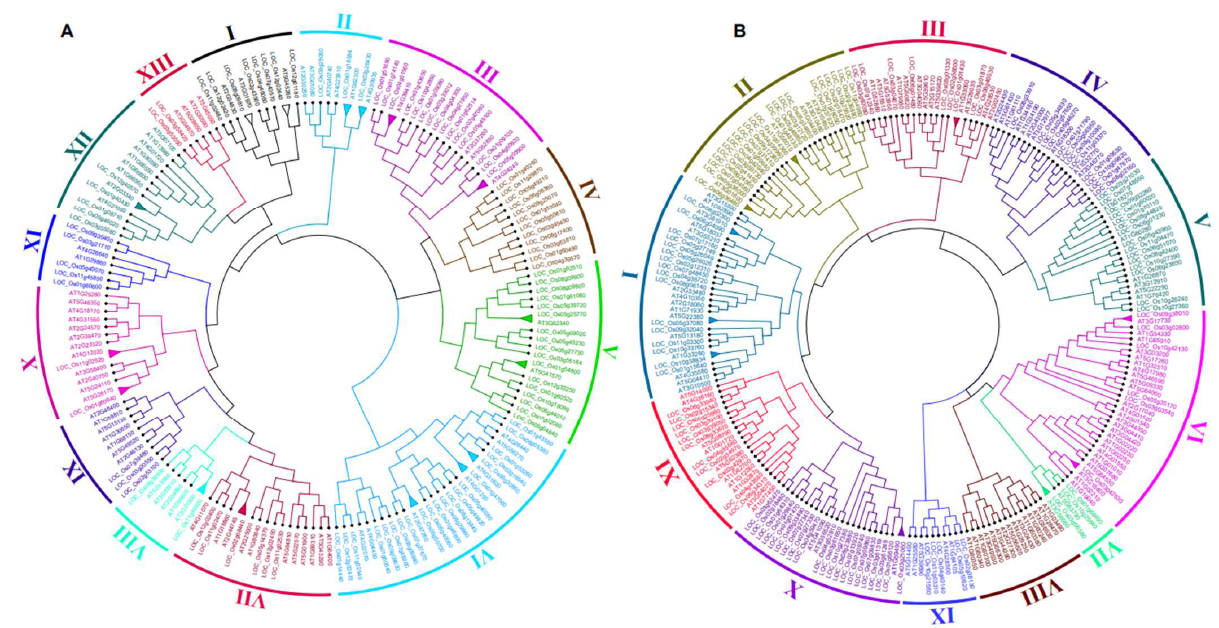
Figure 2. ( A ) Joint phylogenetic tree constructed from an alignment of 101 Oryza sativa ( OsWRKYs ) and 72 Arabidopsis thaliana ( AtWRKYs ) protein sequences via the NJ method with bootstrapping (1000 replicates) using MEGA-11 software. The resulting thirteen groups are shown in different colors. ( B ) Joint phylogenetic tree constructed from an alignment of 121 Oryza sativa ( OsNACs ) and 110 Arabidopsis thaliana ( AtNACs ) proteins sequences via the NJ method with bootstrapping (1000 replicates) using MEGA-11 software. The resulting eleven groups are shown in different colors.